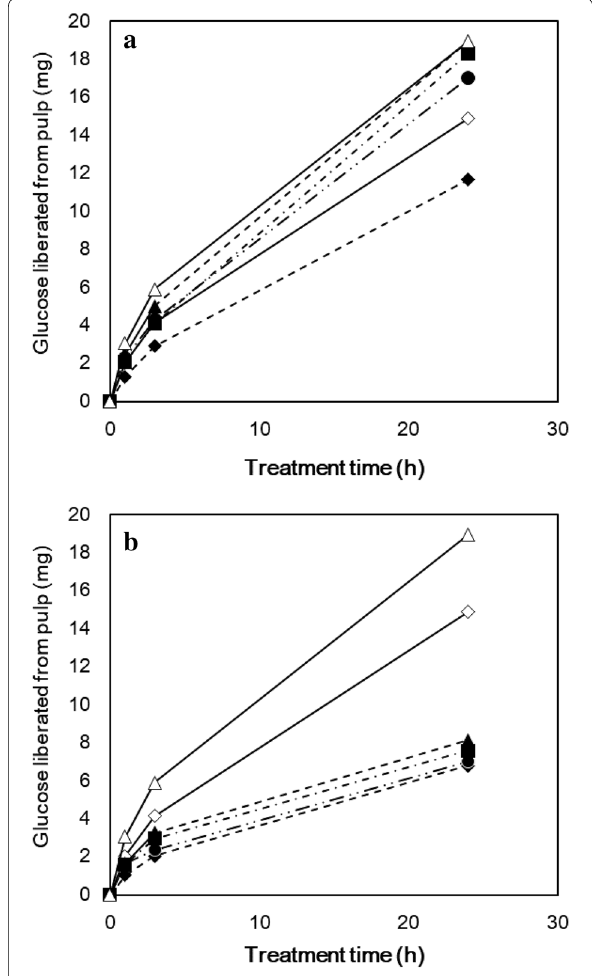
Fig. 6 Enzymatic saccharification of beaten pulp with enzyme at 12.7 FPU/g: a larch SP with the kappa number 74.6 and b acacia SP with the kappa number 52.3. Solid diamond, solid circle, solid square and solid triangle: the number of PFI revolutions 0, 2500, 5000, and 7500, respectively, and open diamond, open triangle: filter paper, PFI revolutions 0 and 7500, respectively. Enzymatic treatment: pulp 50 mg, Acetate buffer pH 4.5 and 1.5 mL and temperature at 45